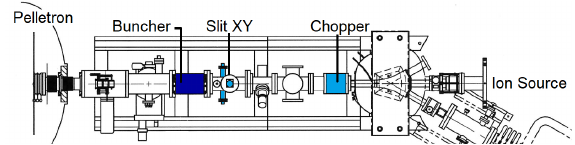
Figure 2. Schematic layout of the pulsed system installed on the Tandem accelerator, with the chopping (light blue) and the bunching (dark blue) elements.